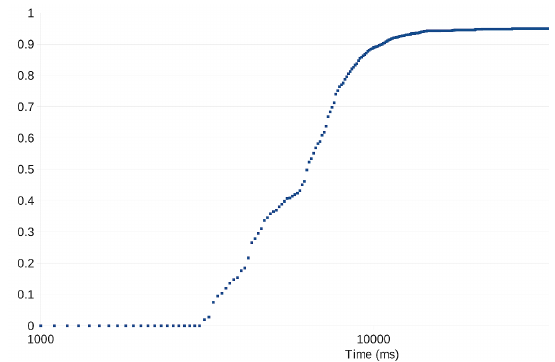
Figure 7. CDF of 1450 Connection Times. 75% of connections take less than 8 seconds.